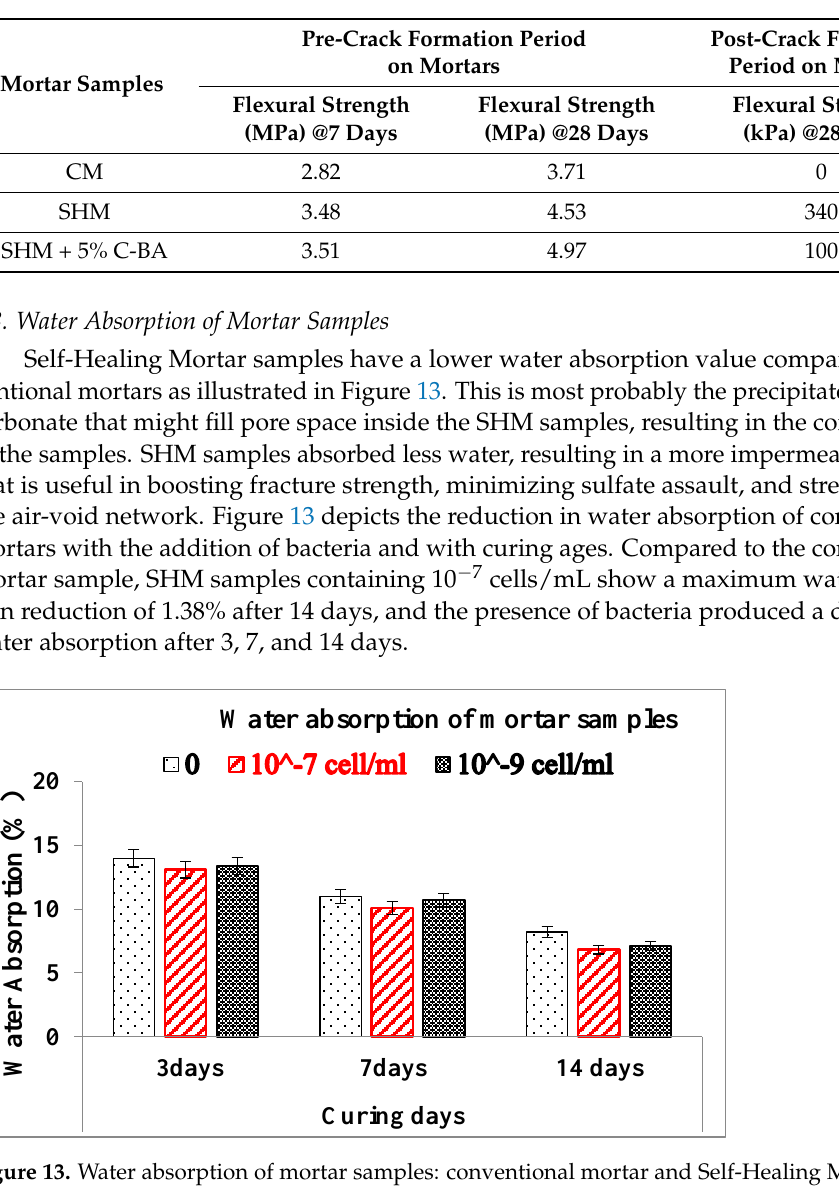
Table 3. Flexural strength ( σ F) of Conventional Mortars (CM), Self-Healing Mortars (SHM), and